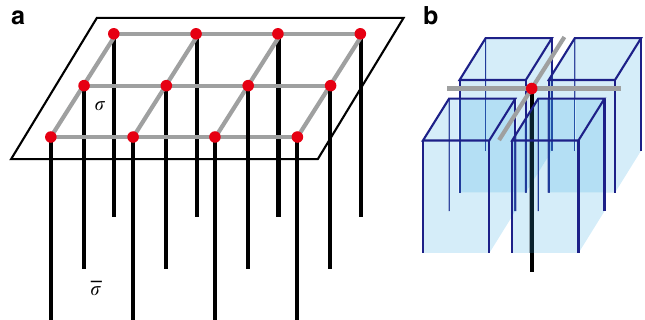
Fig. 7 Mapping between HOLSM in 2D and TCS in 3D. a Mapping between a 2D G -complex Y and a 3D G -complex (cid:1) Y . Y can be viewed as the boundary of (cid:1) Y . b Illustration of a 3-block bubbling process in (cid:1) Y . On the second page, such a process trivializes a 1-block assembly in (cid:1) Y and generates a 2-block SPT in Y